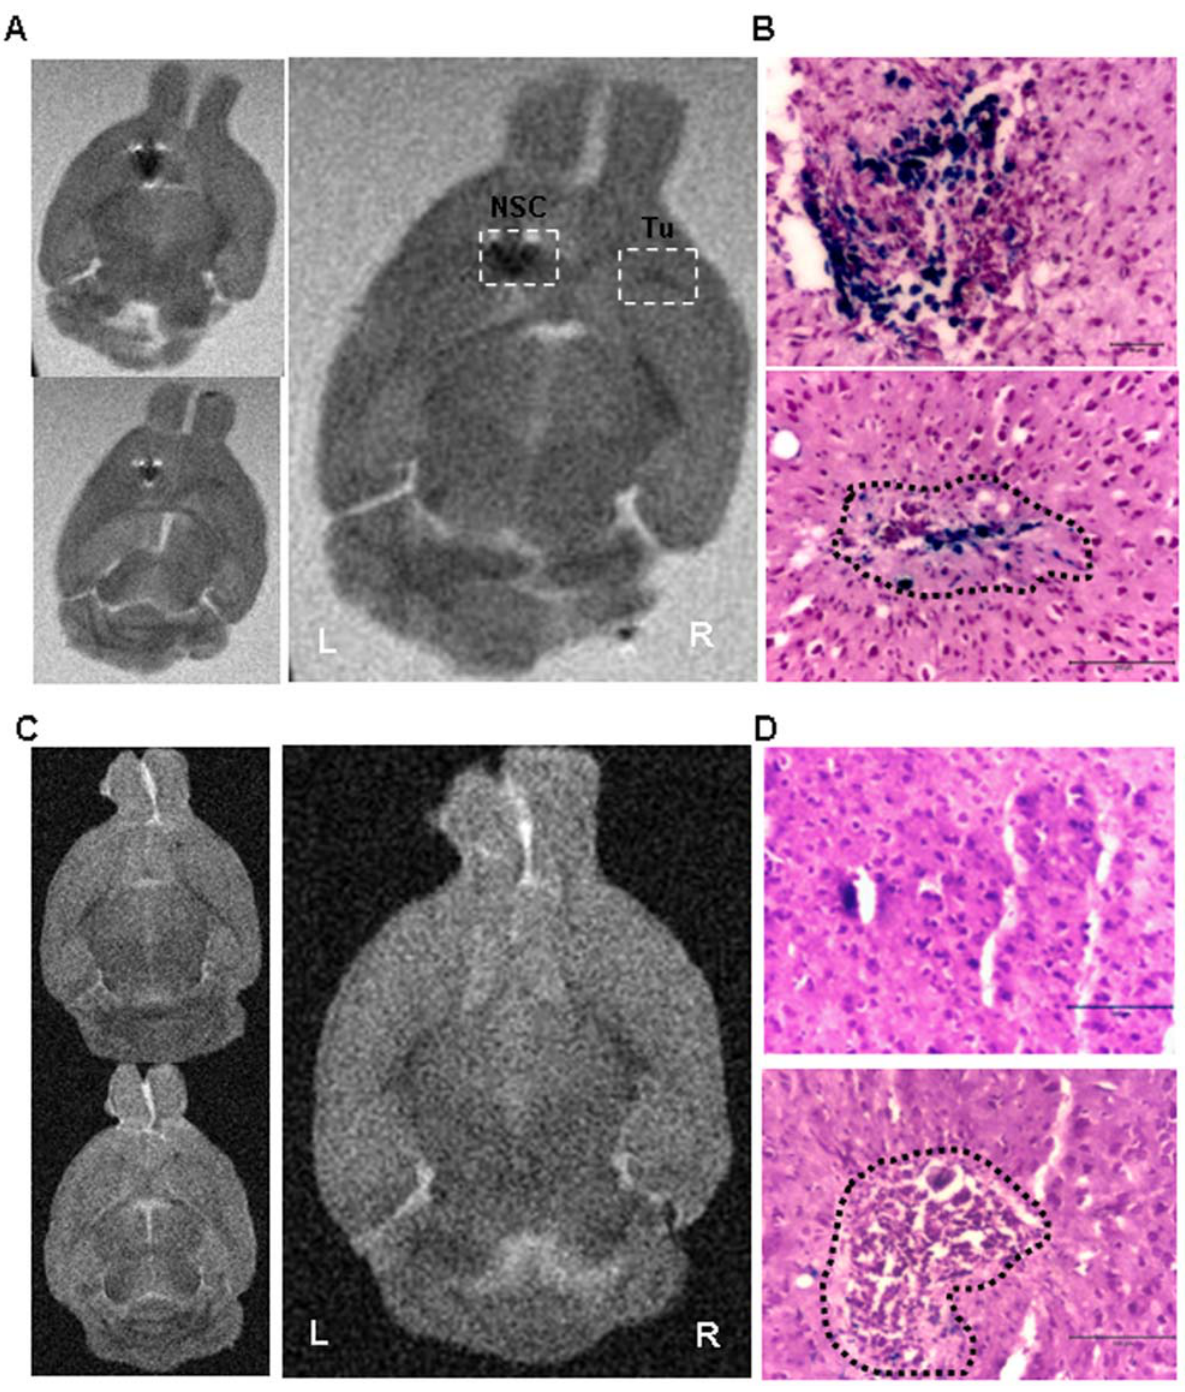
Figure 4. MRI Visualization of FE-Pro-labeled NSCs targeting human glioma in an orthotopic mouse model. (A) Consecutive T2- weighted MR images of mouse brain in 30% sucrose and 4% PFA. FE-Pro-labeled NSCs are shown as hypointense (dark) signals (white dotted boxes) in the left hemisphere and in the contralateral right hemisphere, where human U251 glioma cells were implanted. (B) Higher magnification, Prussian blue stained sections from the areas outlined by the boxes in (A) (top, left hemisphere; bottom, right hemisphere, tumor area outlined by black dotted line). (C) Consecutive T2-weighted MRI images of mouse brain in Fomblin that received PBS sham injection on left hemisphere and human glioma U251 on the right hemisphere. No low-intensity signals were detected in this control. (D) Higher magnification, Prussian blue stained sections from the areas outlined by the boxes in (C) (top, left hemisphere; bottom, right hemisphere, tumor area outlined by black dotted line). MRI conditions: 7.0 Tesla, Rapid Acquisition Relaxation Enhancement sequence, 78 m m/pixel, 300 m m/slice, T R /T E =1500/23.1 ms. Scale bars=100 m m (B and D) .